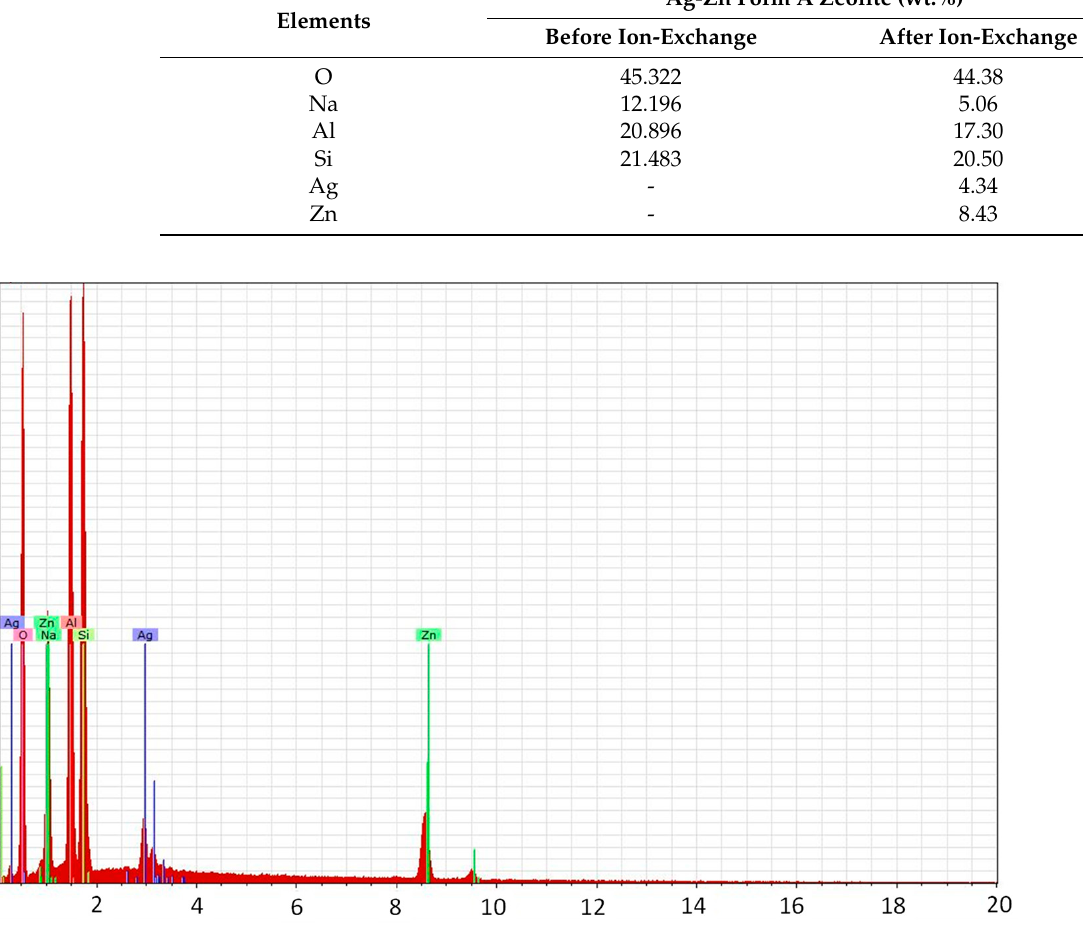
Figure 3. EDX results of Ag-Zn form A zeolite.